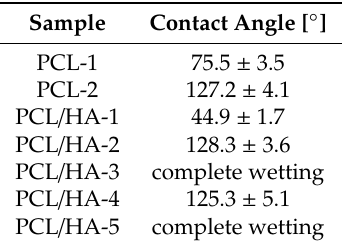
Table 4. Results of contact angle